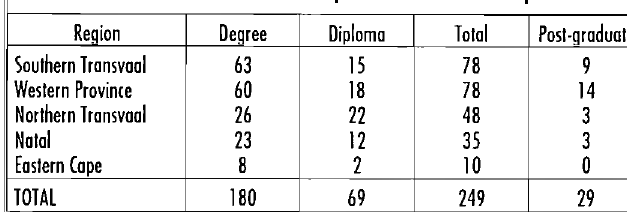
Table 1. Qualifications of respondent OMTG therapists